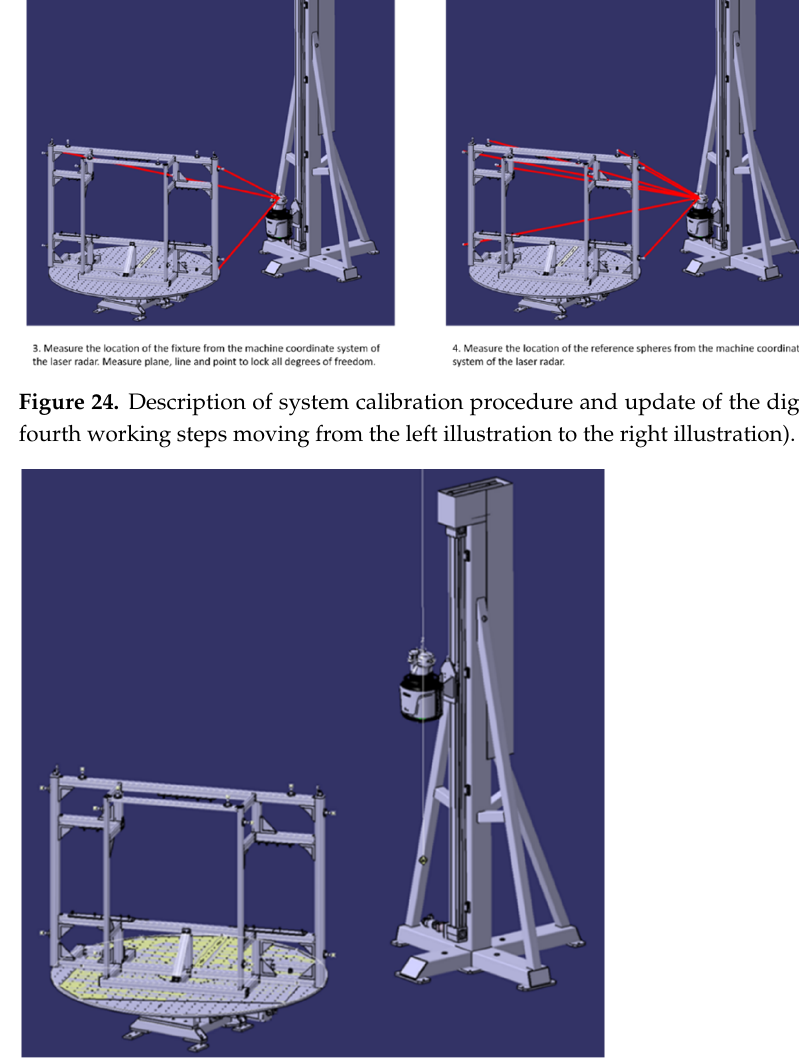
Figure 25. Description of system calibration procedure and update of the digital twin. Fifth and six working steps.